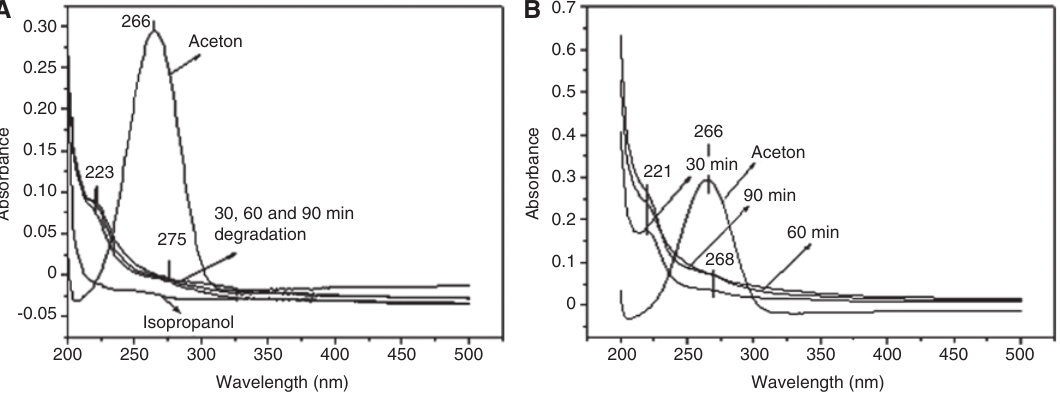
/G and (B) CdS-TiO /G as a photocatalyst of monochromatic light at 380 nm 2 2